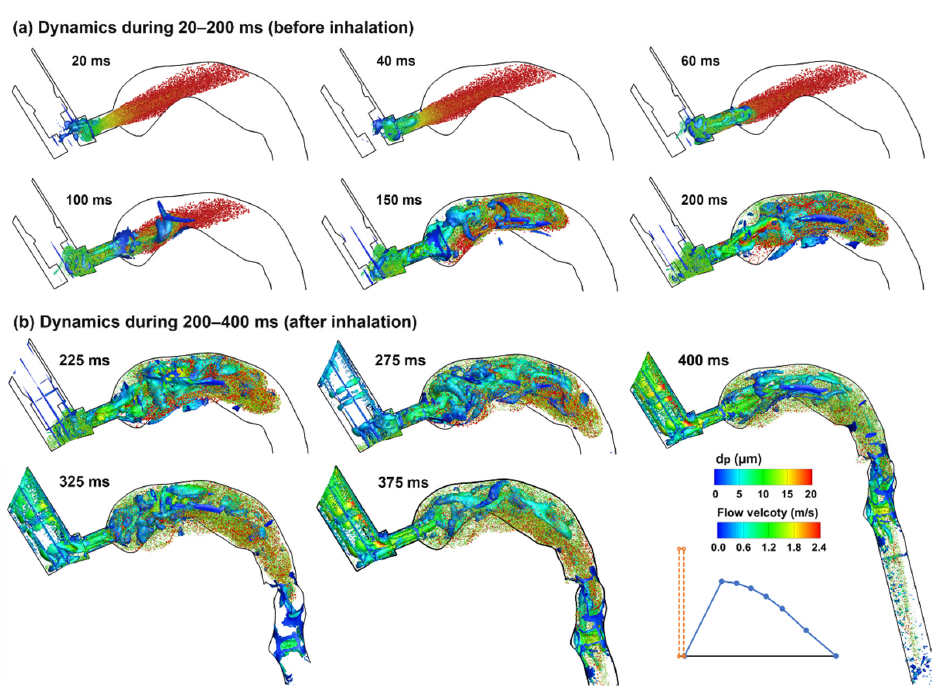
Figure 10. Droplet dynamics in the upper airway at varying instants (20–400 ms) when actuating the inhaler before inhalation: ( a ) dynamics during 20–200 ms, and ( b ) dynamics during 200–400 ms. Droplets were scaled and colored by droplet diameters. The Q-criterion iso-surfaces were colored by flow velocity.